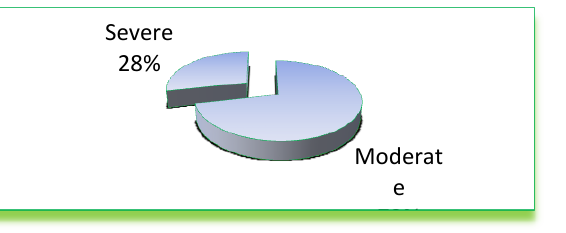
Figure 9: The patients demographic data.